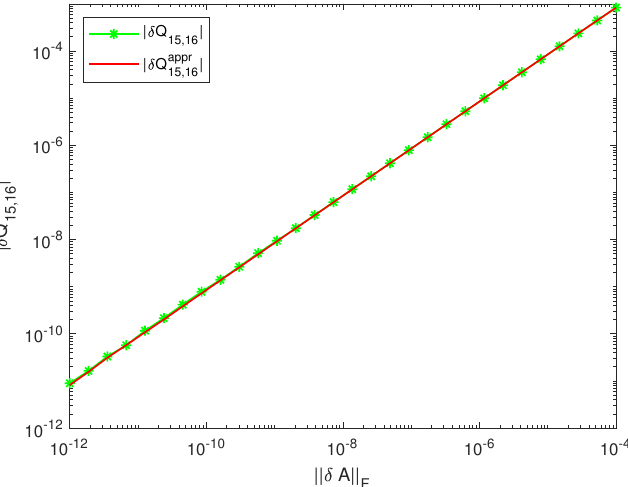
Figure 4. Exact values of δ Q 15,16 and its bounds as functions of the perturbation norm.